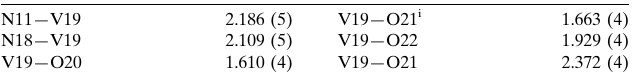
Selected bond lengths (A ˚ ).